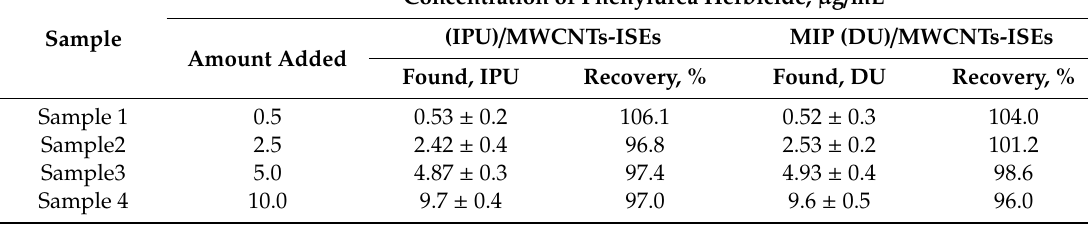
Table 3. Application of the proposed method to determination of phenylureas in spiked wastewater